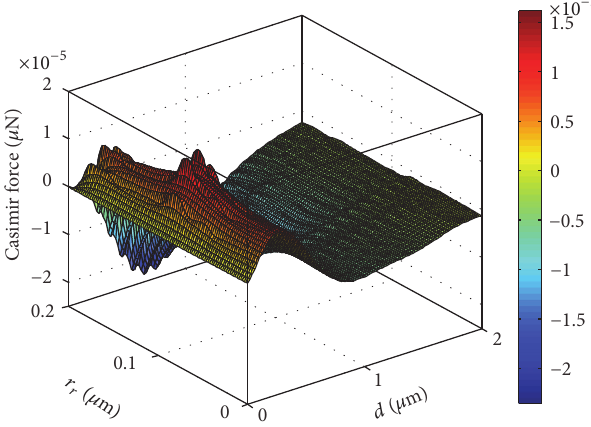
Figure 4: The repulsive Casimir force as a function of different minor radius of ellipsoid and different separation between gold ellipsoid and plate.